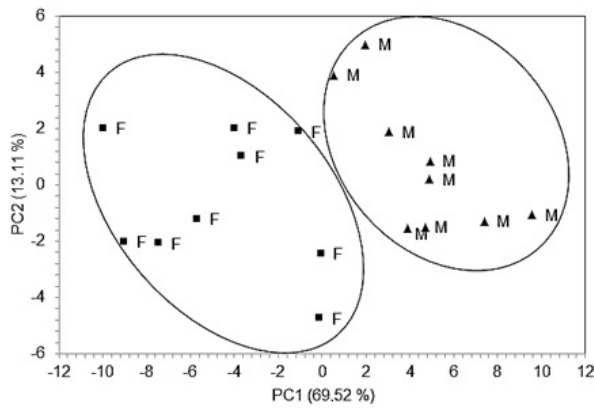
Figure 1. Principal component analysis (PCA) plots for Nellore beef cattle. PCA plots were generated from the FA profile consider- ing cattle sex, i.e., bulls (M) and heifers (F). PC1 and PC2 represent principal components 1 and 2,